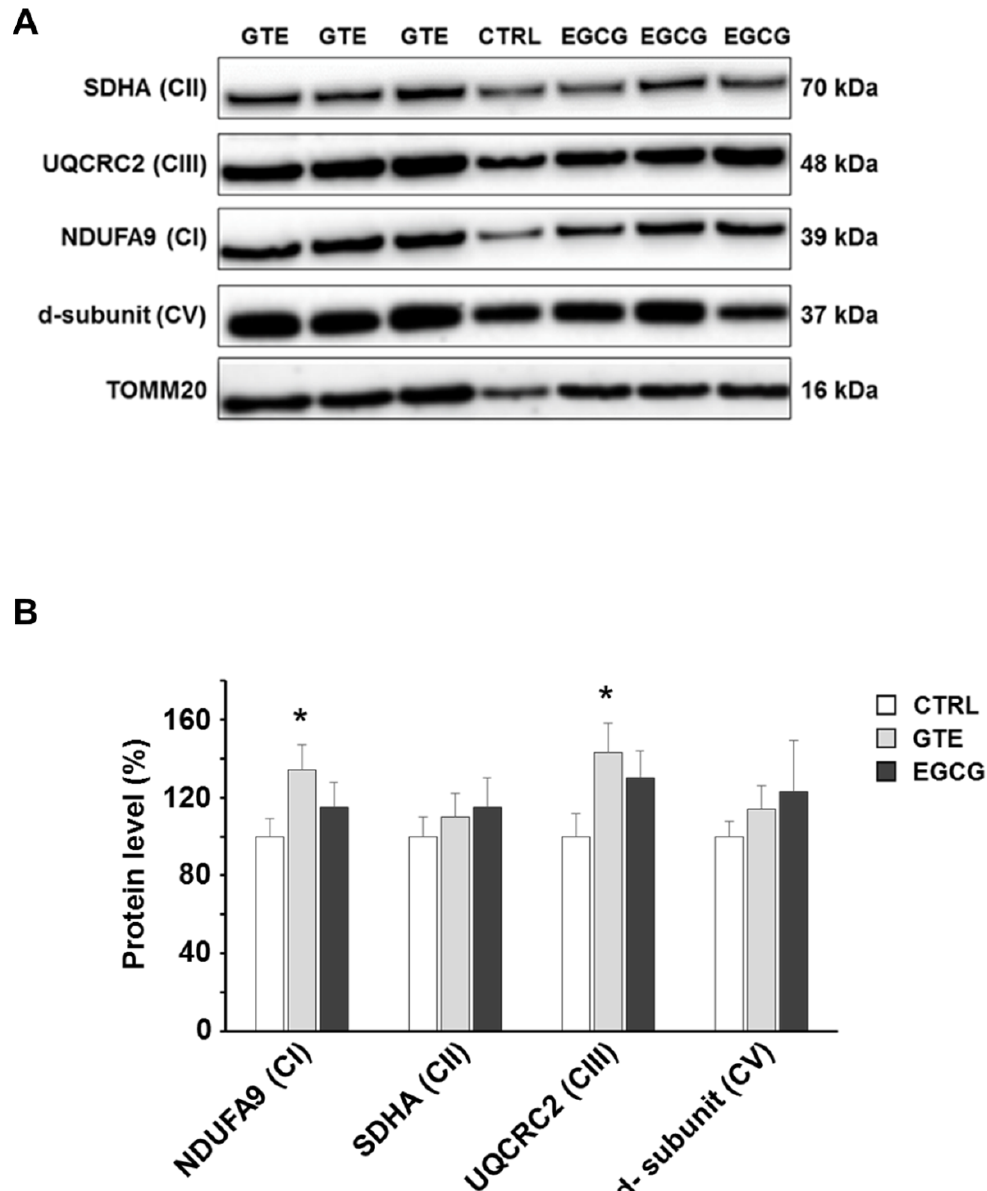
Figure 3. OXPHOS complexes level in GTE and EGCG rat LV tissue. ( A ) Typical electrophoretic separation and immunodetection of OXPHOS complexes in LV tissue lysates of CTRL ( n = 2), GTE- ( n = 3), and EGCG-supplemented rats ( n = 3). ( B ) Subunit level of each OXPHOS complex was determined by means of the ImageLab analysis software and normalized to the TOMM20 protein level, taken as an index of loading control. Histograms show the mean ± SEM; * p < 0.05 indicates the statistical significance of data compared to controls.